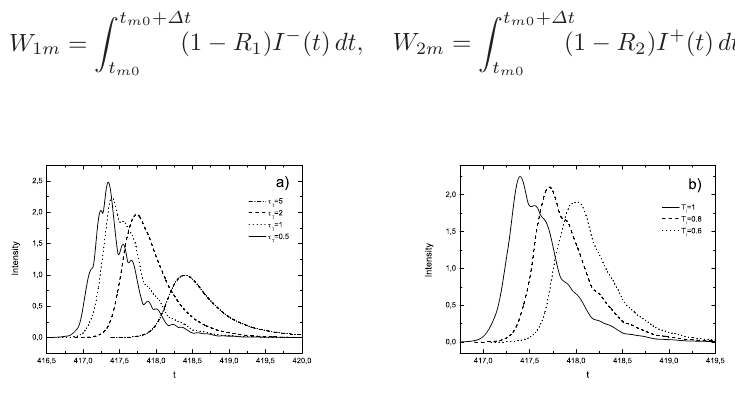
Figure 6. Temporal pulse modulation a) in the case of high rate opening of AQS, b) pulse shape smoothing by additional PQS with high enough transmittance. It is also seen from the normalized intensities that shapes of forward